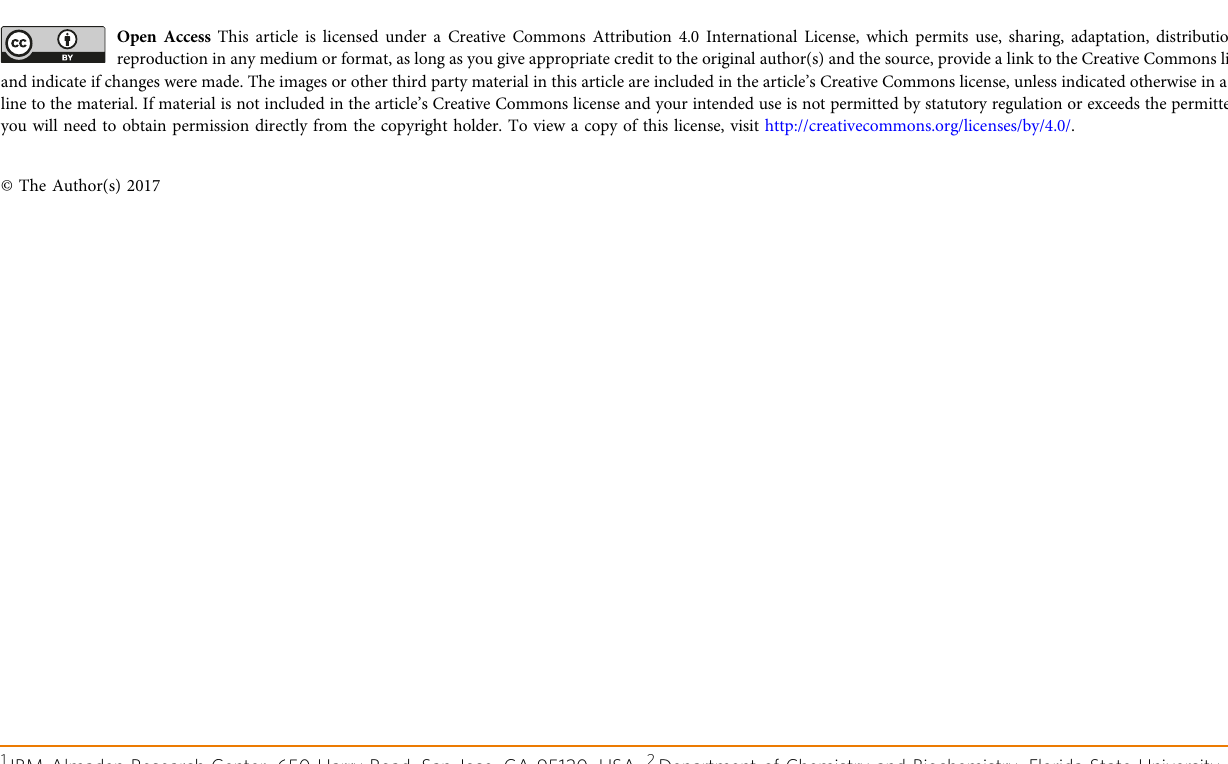
Figure 2 of this article contains errors. In Fig. 2, the 3D structures of the molecules are not shown. The corrected version of Fig. 2 is shown below as Fig.